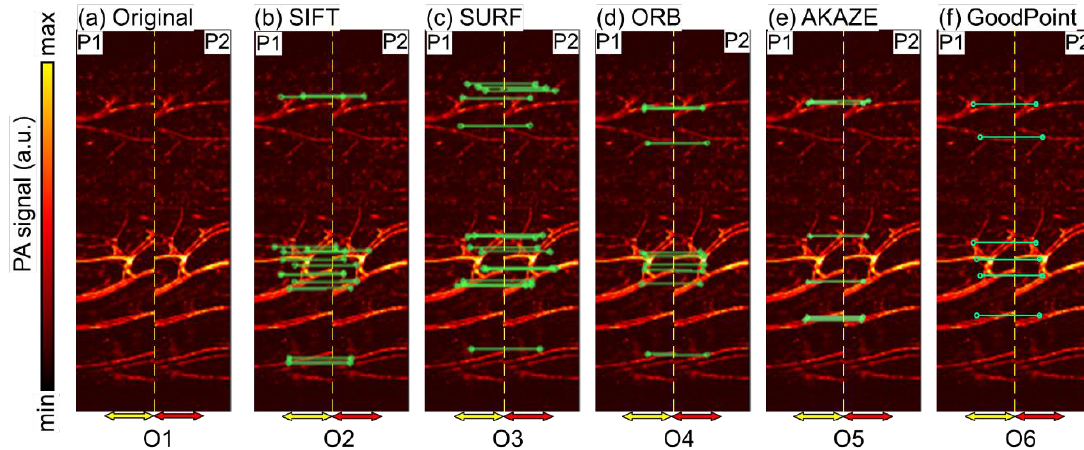
Figure 5. ( a ) Patches of sample P1 and P2 with fixed overlapping range (overlapping O1 to O6 between yellow and red arrow); matching by ( b ) SIFT, ( c ) SURF, ( d ) ORB, ( e ) AKAZE, and ( f ) GoodPoint to match feature point from patches (green